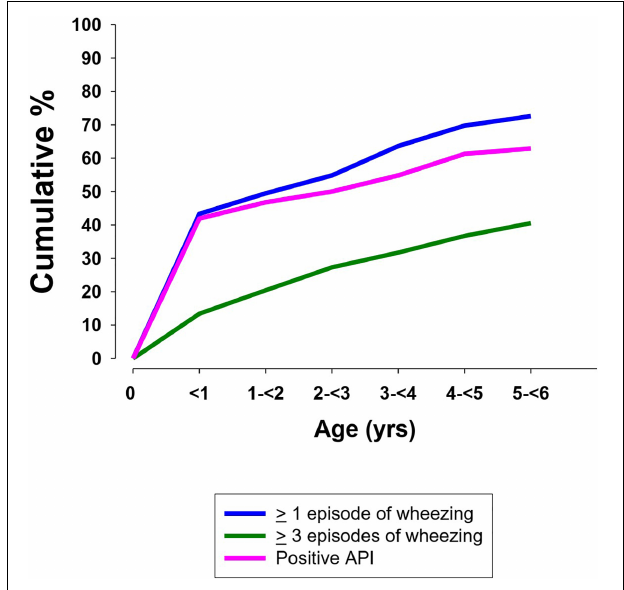
FIGURE 1 | Cumulative frequency of wheezing and a positive Asthma Predictive Index in preschool children ( < 6 years) with CF (13).